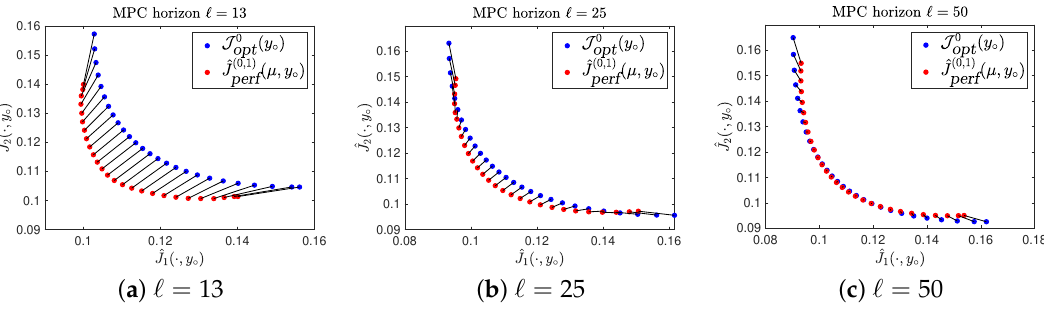
Figure 5. Performance Results.